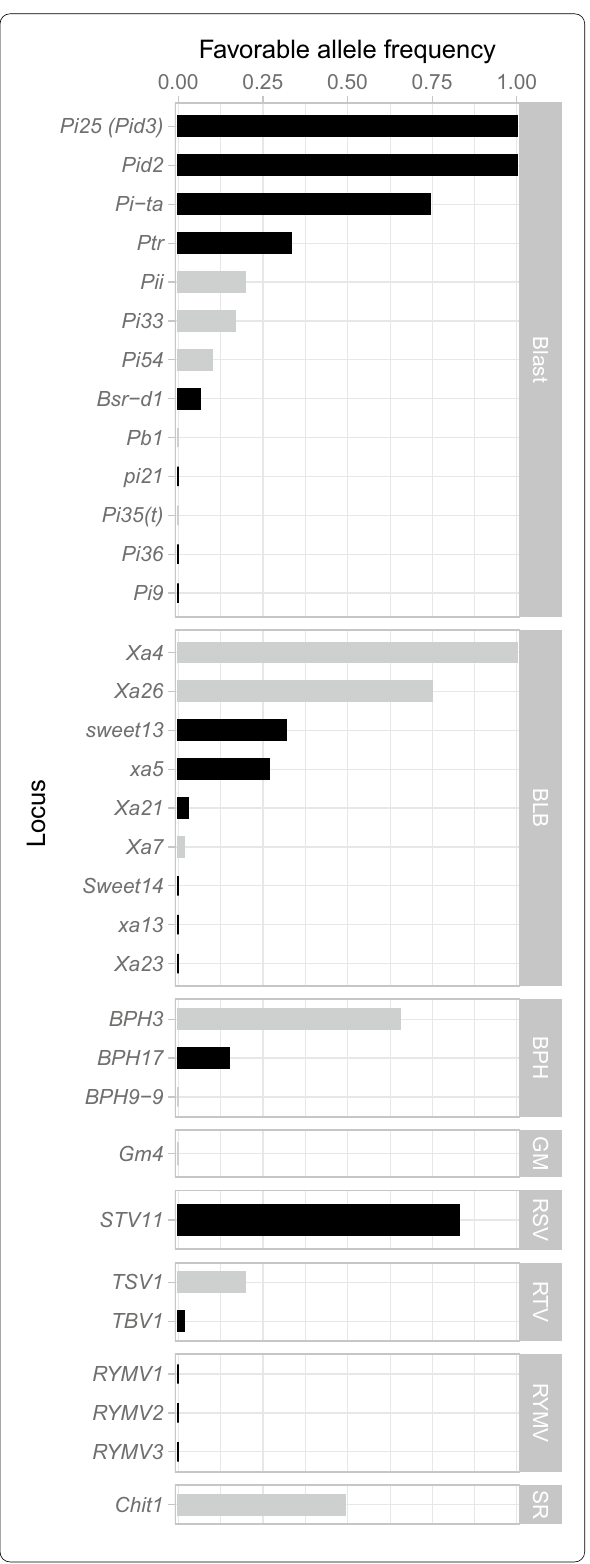
Fig. 7 Frequency of favorable alleles in the elite core panel for 33 genes associated with resistance to major biotic stresses. Genes associated with the following pathogens or pests are presented: rice blast, bacterial leaf blight (BLB), brown planthopper (BPH), gall midge (GM), rice stripe virus (RSV), rice tungro virus (RTV), rice yellow mottle virus (RYMV), sheath rot (SR). The color of bars indicates the percentage of genotypes available to compute the frequency: black more than 95% and grey less than